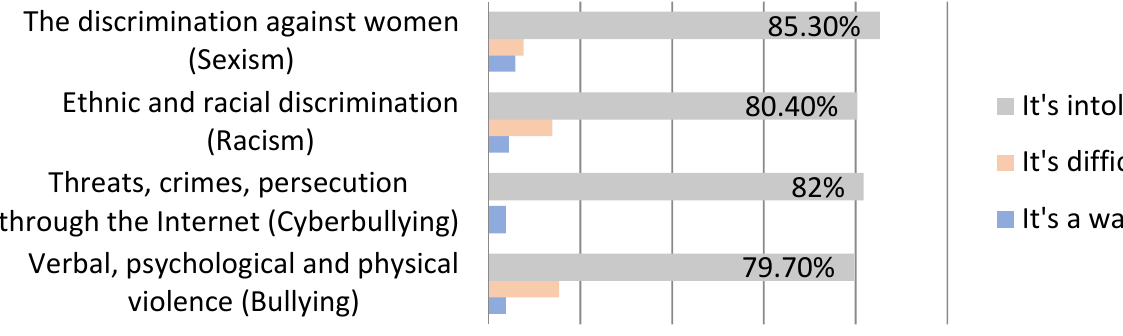
Table 6. Your opinion toward these social